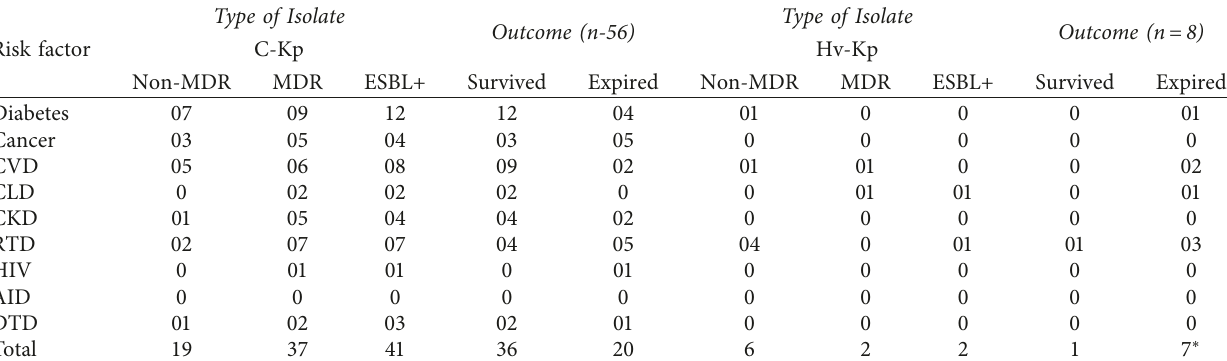
Table 6: Comparison of Risk factors associated with classical Klebsiella pneumoniae (C-Kp) and hypervirulent Klebsiella pneumoniae (Hv- Kp) infections and their outcome.